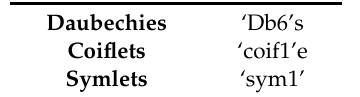
Table 3. Wavelet functions for analysis of CO 2